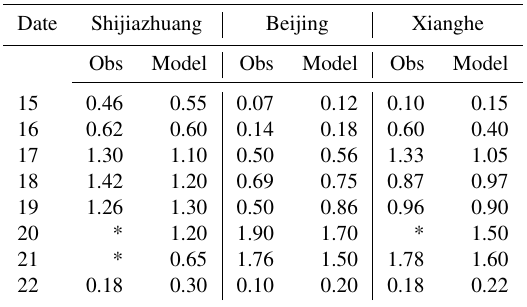
Table 4. Observed and modelled daily AOD (* represents a shortage of observations). Dates refer to December 2016.